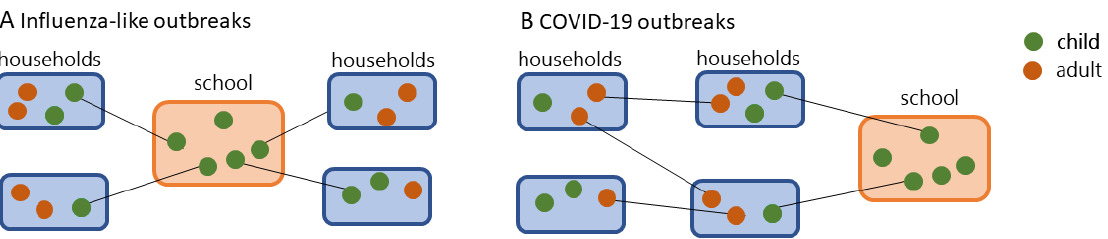
Figure 1. Transmission-dynamic scenario for ( A ) influenza (flu)-like outbreaks as described by Cauchemez [11] and ( B ) COVID-19 outbreaks.